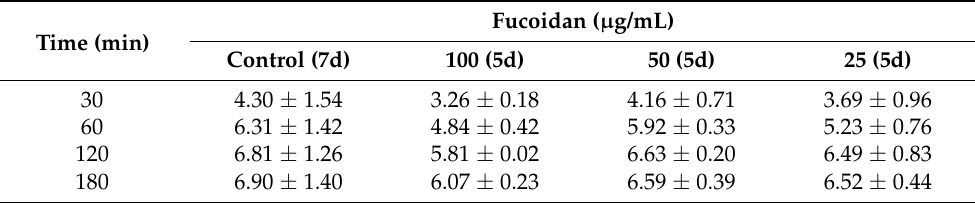
Table 1. The apparent permeability coefficient (Papp) ( × 10 − 7 cm/s) of fluorescein sodium after treatment with different fucoidan concentrations at different times.